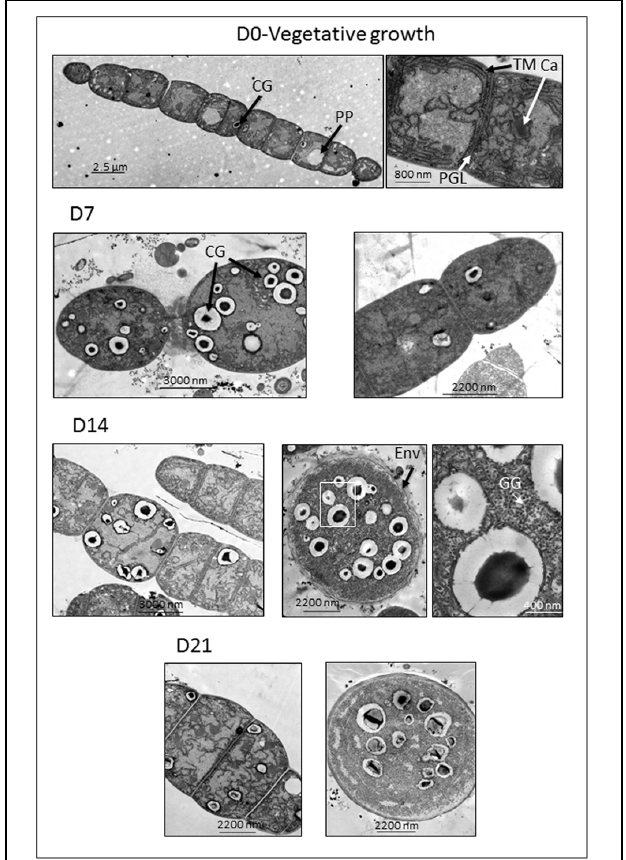
FIGURE 1 | Electron micrographs of ultra-thin sections of filaments and akinetes of Aphanizomenon ovalisporum captured at different time points (D0, day 0; D7, day 7; D14, day 14; and D21, day 21) after akinete-induction (transfer to K + -depleted medium). Ca, carboxysome; CG, cyanophycin globule; GG, glycogen globule; Env, envelope; PP, polyphosphate body; TM, thylakoid membrane. The right electron